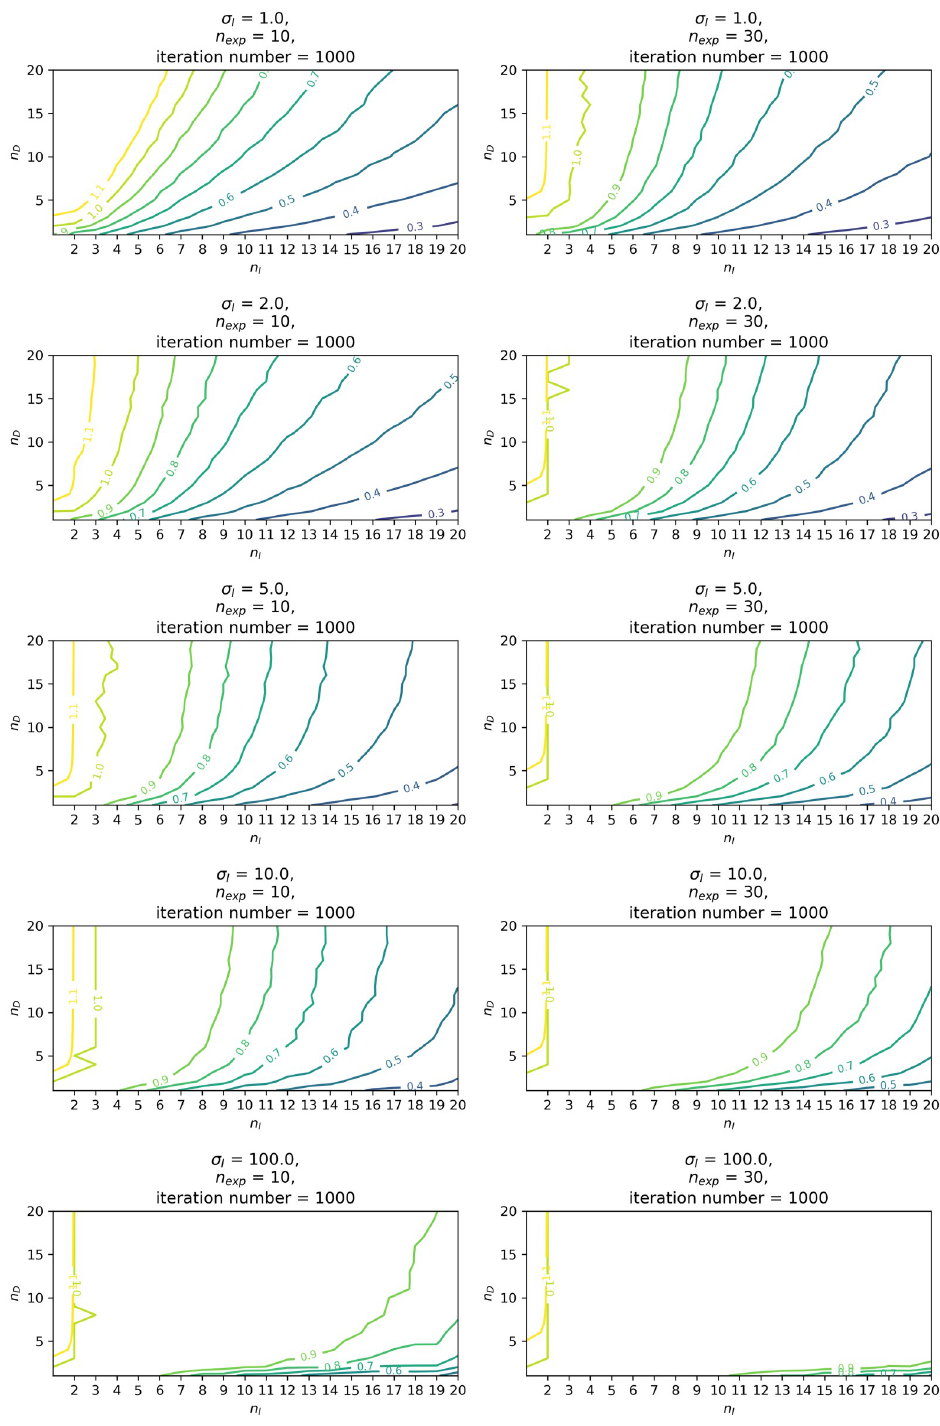
Fig 4. Contour plots for average performance scores for cluster estimation, � r in 1000-steps simulations. Areas near the score of 1.0 represents areas of parameter combinations where perfect estimation scores returned.